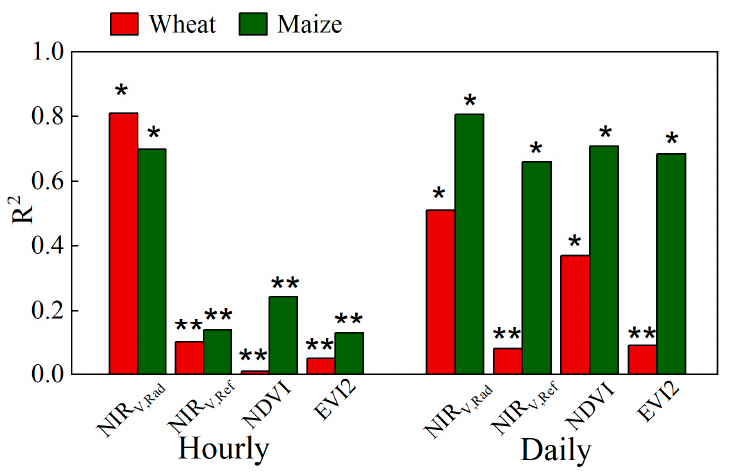
Figure 5. Squared Pearson correlation coefficients (R 2 ) of the NPP proxies (NIR v,Rad , NIR v,Ref , NDVI, and EVI2) with the measured NPP of winter wheat and summer maize on hourly and daily scales. Asterisk denotes statistically significant differences * p<0.05, ** p<0.01. There were clear differences between the slopes of the NIR v,Rad –NPP relationships of winter wheat and summer maize, which reflect the potential of NIR v,Rad to track NPP. The NIR v,Rad –NPP slope of winter wheat was higher than that of summer maize on both hourly and daily scales, indicating that the NPP of winter wheat is more susceptive to tiny variation in NIR v,Rad than that of summer maize. When NPP does not show large changes, NIR v,Rad might not be sensitive to winter wheat NPP and may be more effective in monitoring summer maize NPP. The daily observation data yielded similar results, wherein the slope of summer maize (5.195) was significantly lower than that of winter wheat (7.257). However, this difference in slopes on the daily scale (2.062) was smaller than that on the hourly scale (5.155), indicating that NIR v,Rad may be more susceptive to hourly NPP detection (Figure 6b).